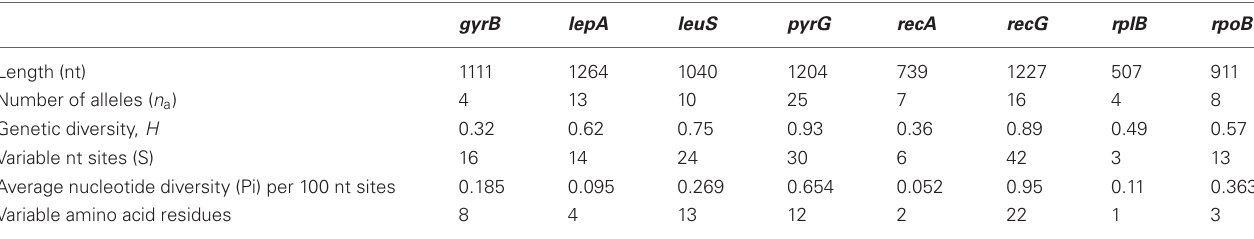
Table 3 | Characteristics of eight protein coding loci examined from the set of 106 T. uzonensis strains isolated from hot springs of the Uzon Caldera. gyrB lepA leuS pyrG recA recG rplB